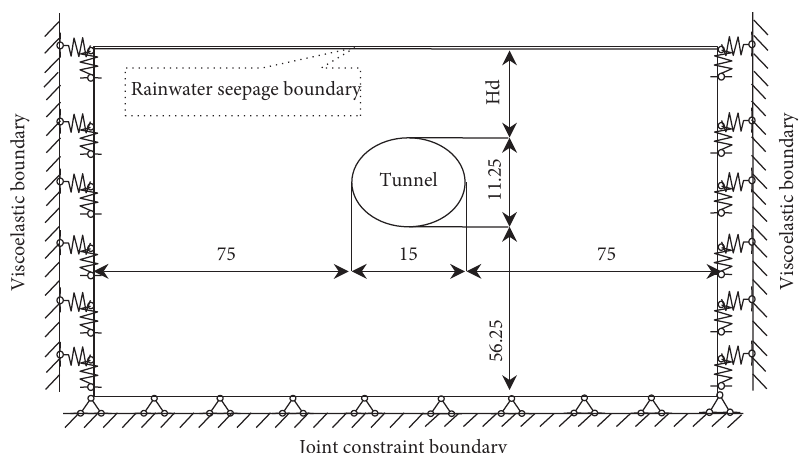
Figure 2: Sketch map of the dynamic analysis model (unit: m).